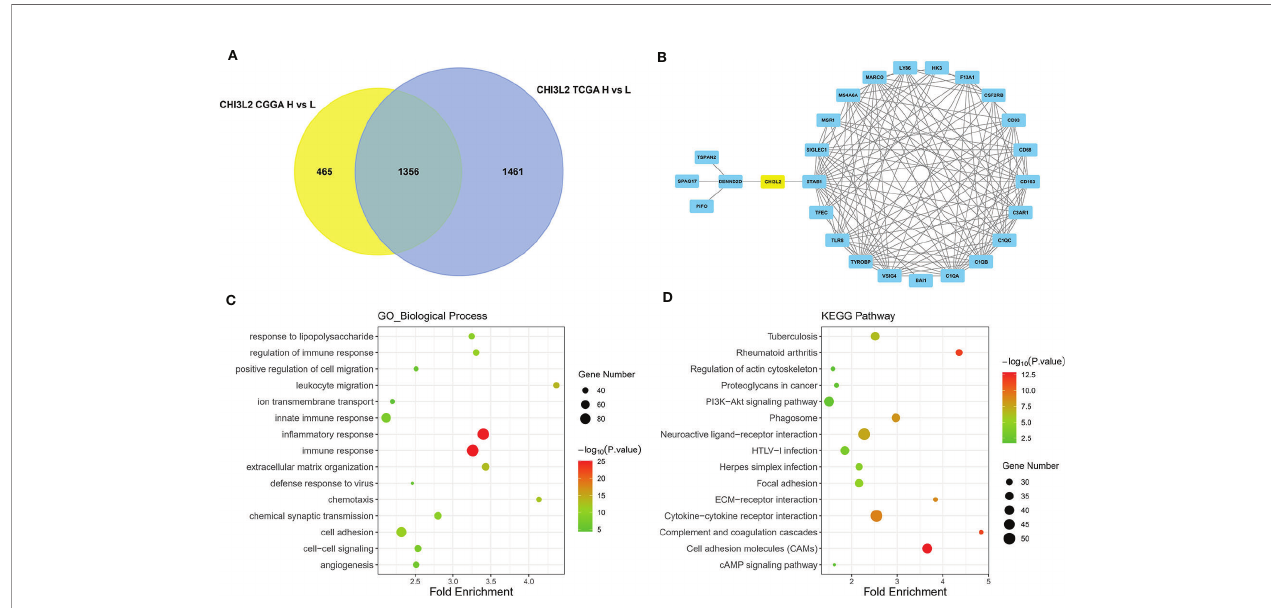
FIGURE 6 | Identi fi cation of DEGs, hub genes, functions, and pathways of CHI3L2 in gliomas. (A) The Venn diagrams show a total of 1356 overlapping DEGs identi fi ed from TCGA and CGGA datasets. (B) The 26 hub genes are screened out by the cytoHubba plugin of Cytoscape software. (C) GO analysis shows multiple biological processes of the overlapping DEGs. (D) Several pathways of the overlapping DEGs are identi fi ed by KEGG analysis.